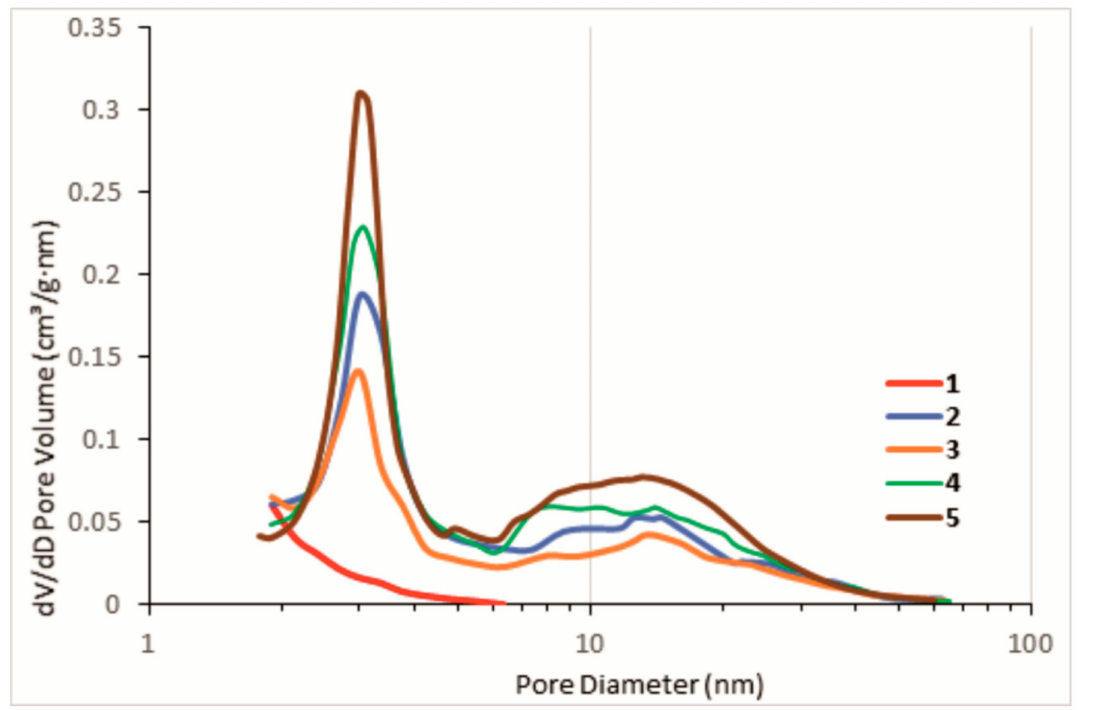
Figure 5. Mesopore size distribution for the HKUST-1@BPS composites, the pristine HKUST-1 mw reference sample, and the bare BPS matrix.